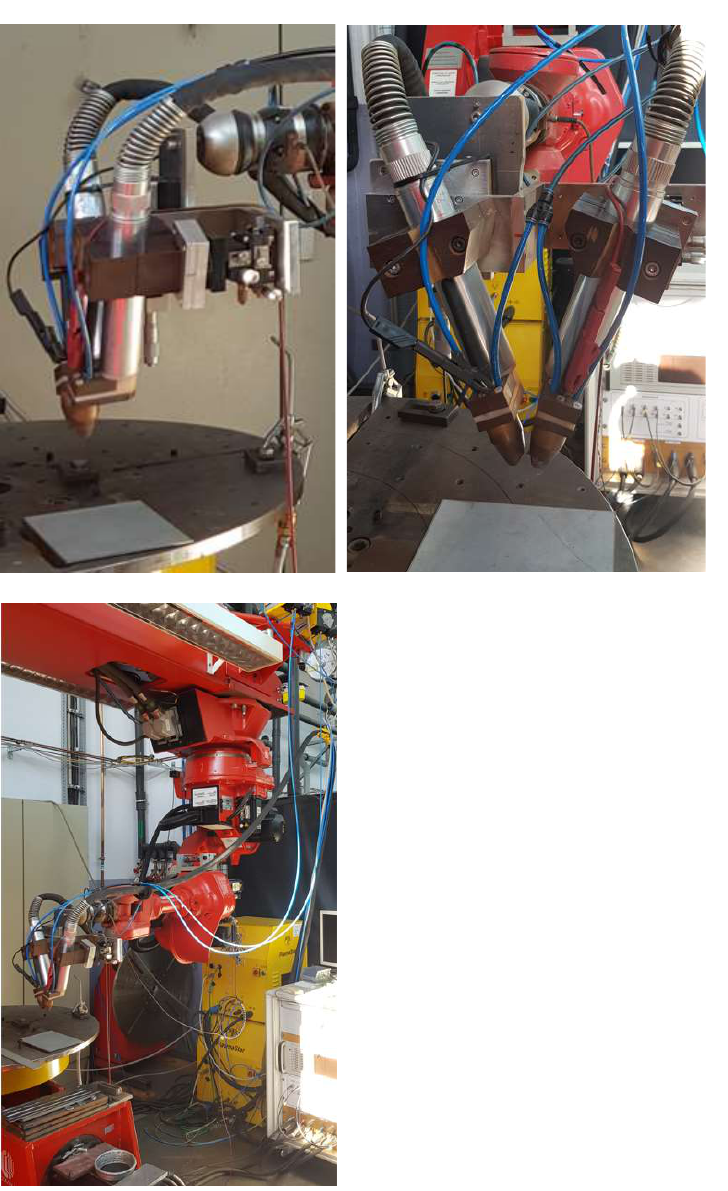
Figure 2. Tandem PTA with handling system (TU Chemnitz).